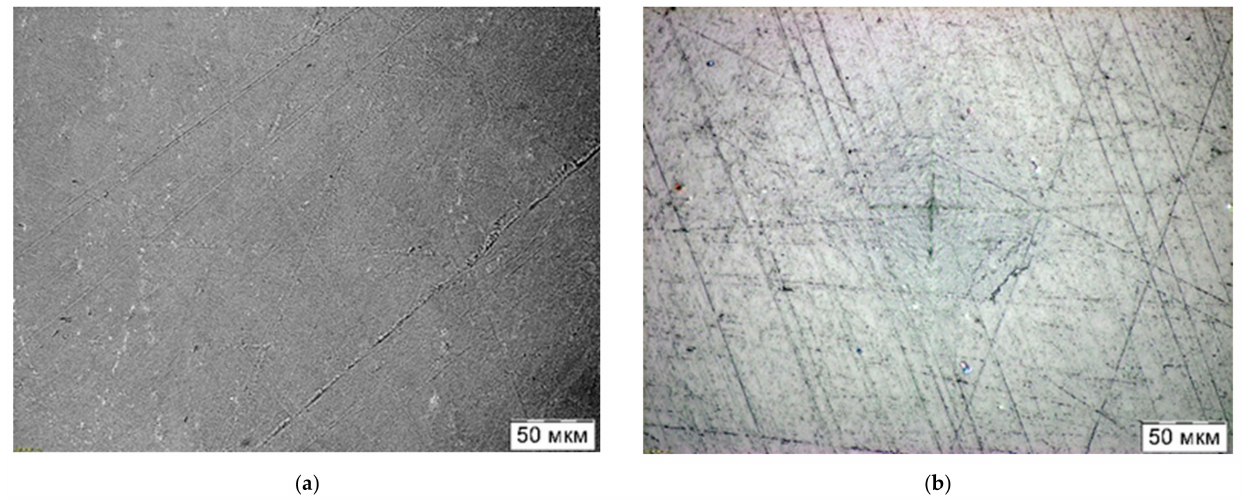
Figure 10. Microstructure of compacts made from the UHMWPE + 0.5 wt.% NDC mixture ( a ) and from pure UHMWPE ( b